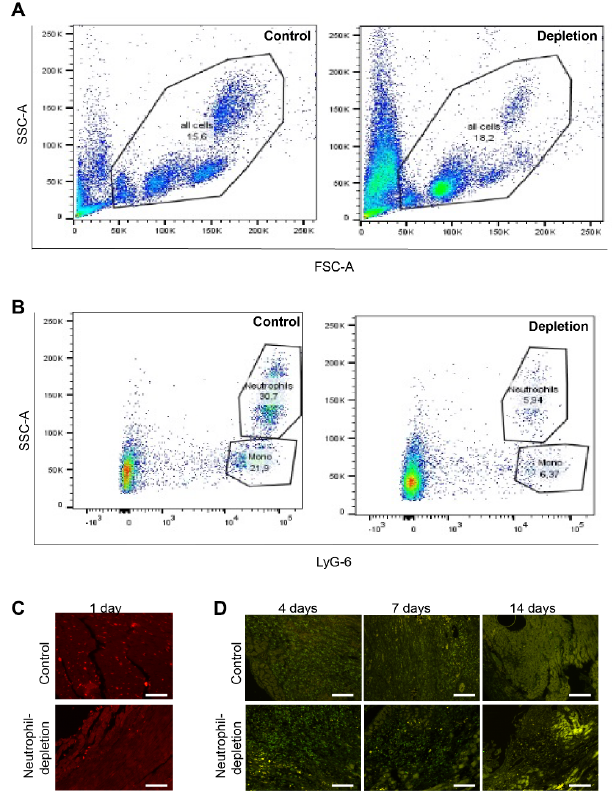
Figure 3. Validation of neutrophil-depletion treatment. Mice undergoing neutrophil depletion showed a significant reduction in blood neutrophils ( A ) and some inflammatory monocytes ( B